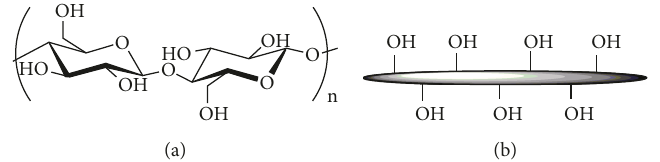
Figure 7: (a) Chemical structure of cellulose polymer; (b) representation of a cellulose nano fi bre or nanocrystal: a rod with abundant free surface pending -OH (primary or secondary)